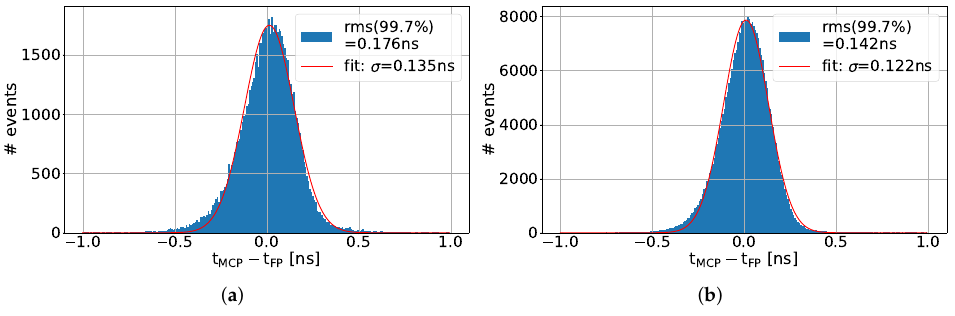
Figure 14. Seed-pixel time residuals after timewalk correction for the inner region of the 10µm ( a ) and 20µm ( b ) pitch